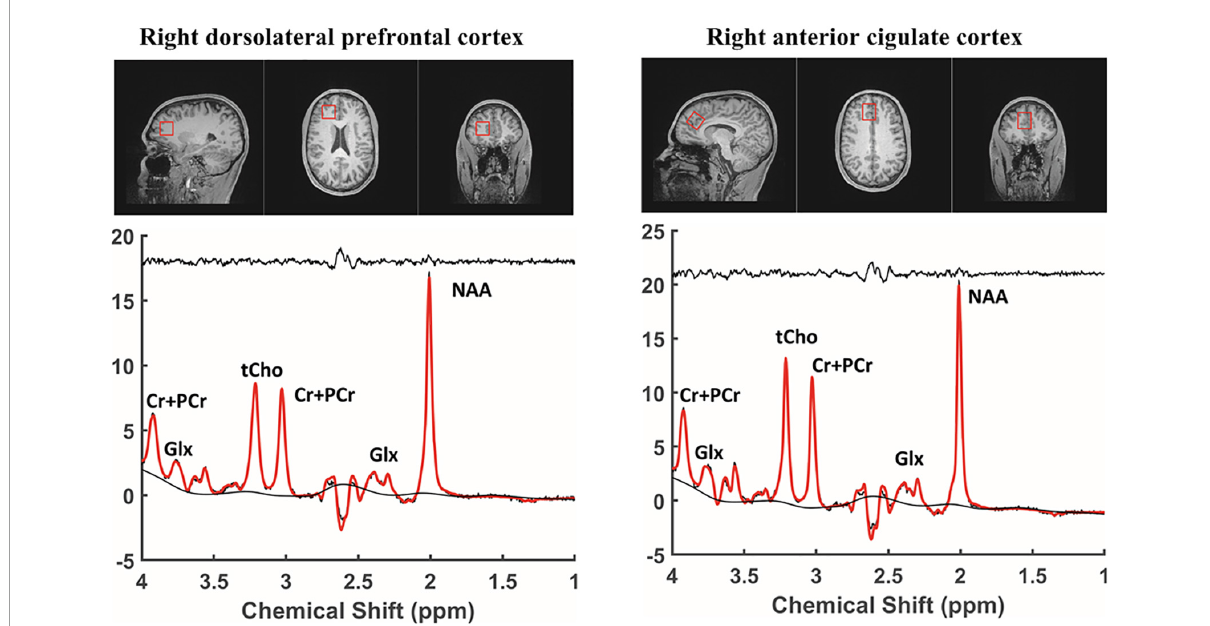
FIGURE1 Regions of interest and MRS spectrum. MRS, proton magnetic resonance spectroscopy; NAA, N-acetyl-aspartate; Glx, Glutamate + Glutamine; tCho, total choline; Cr + PCr, Choline + phosphatidyl